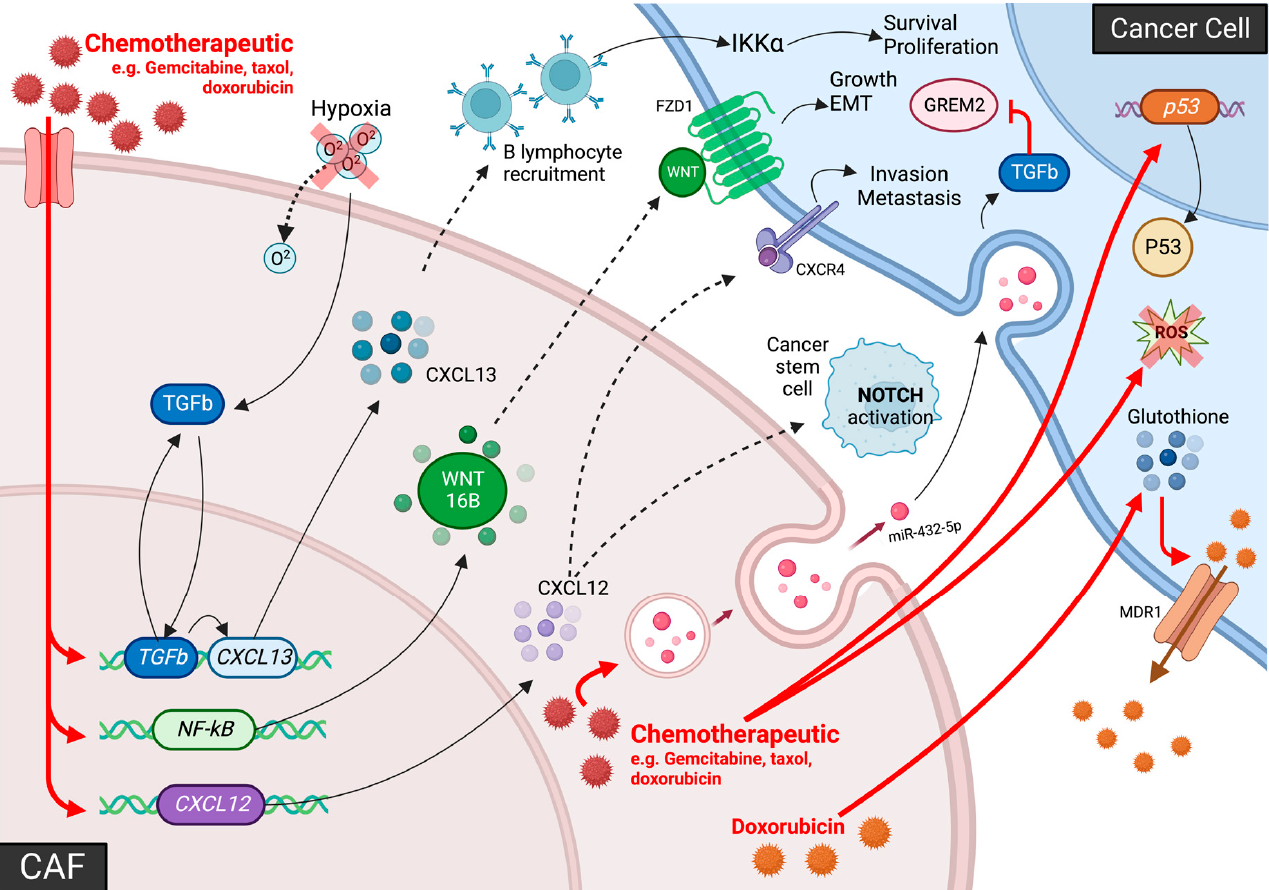
Figure 2. Overview of potential CAF-regulated resistance mechanisms to chemotherapy. Schematic shows the diverse molecular mechanisms that have been identified in the literature to be regulated